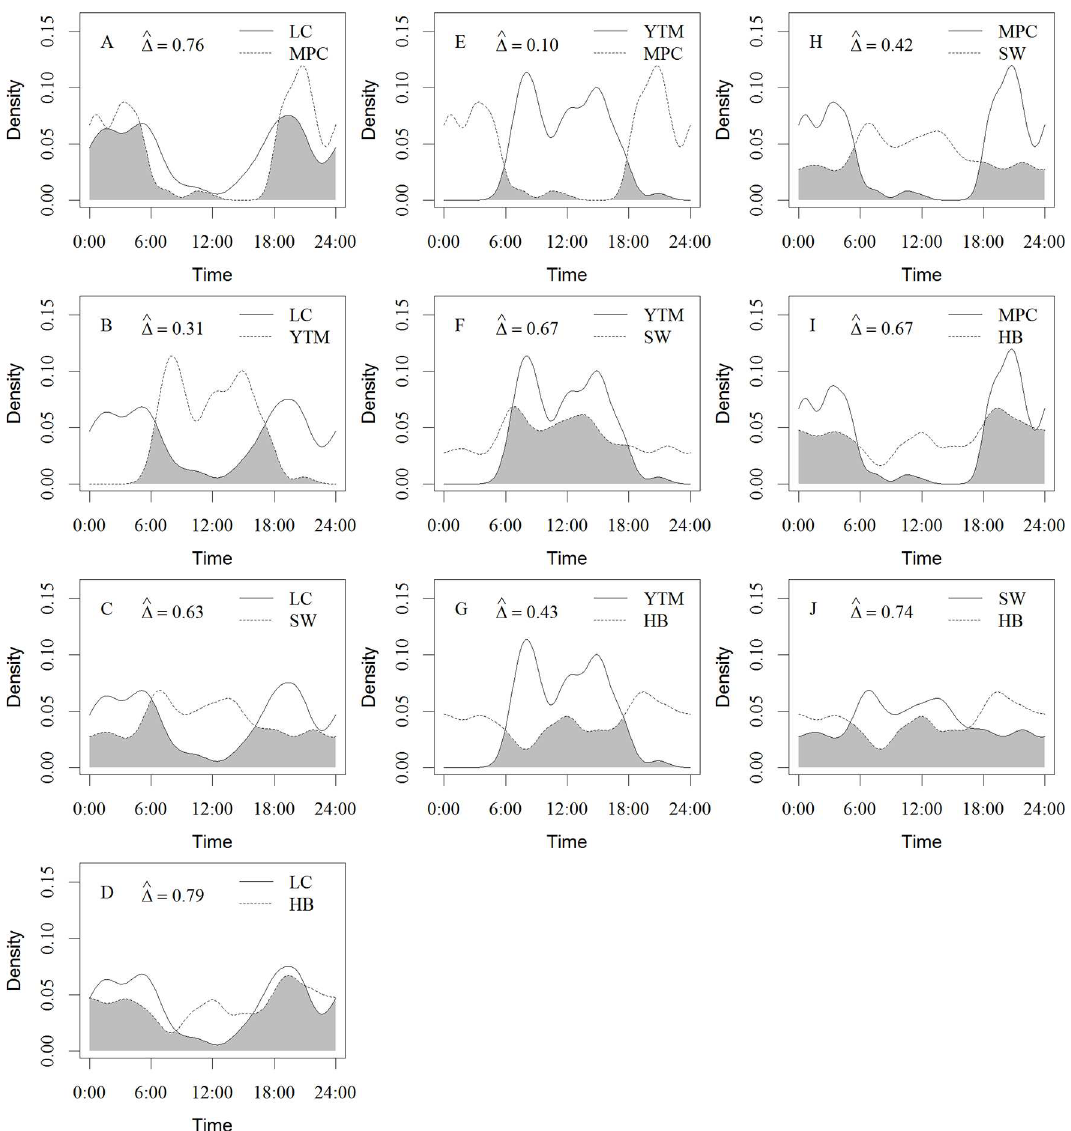
Fig 3. Diel activity patterns and temporal overlap in the species of mesocarnivore guild during warm season (March to November) in Southwest China. The y-axis is the “Kernel Density Estimates”. The overlap area was denoted in grey. The species abbreviations of species’ names are LC-leopard cat, MPC-maskedpalm civet, HB-hog badger, SW-Siberianweasel, and YTM-yellow-throated